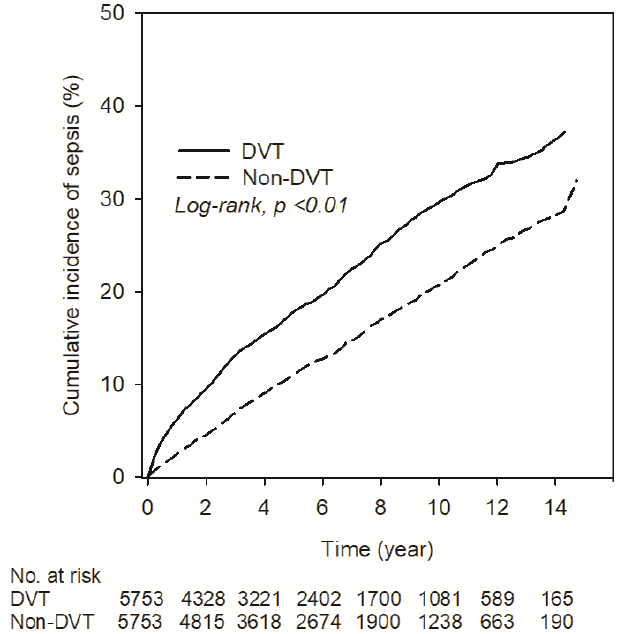
Figure 2. Kaplan–Meier curves of the cumulative proportions of sepsis in DVT patients. Figure 2. Kaplan – Meier curves of the cumulative proportions of sepsis in DVT patients. Table 2. Poisson regression of relative risk of DVT and non-DVT patients. Table 3. Cox proportional hazard model analysis for risk of